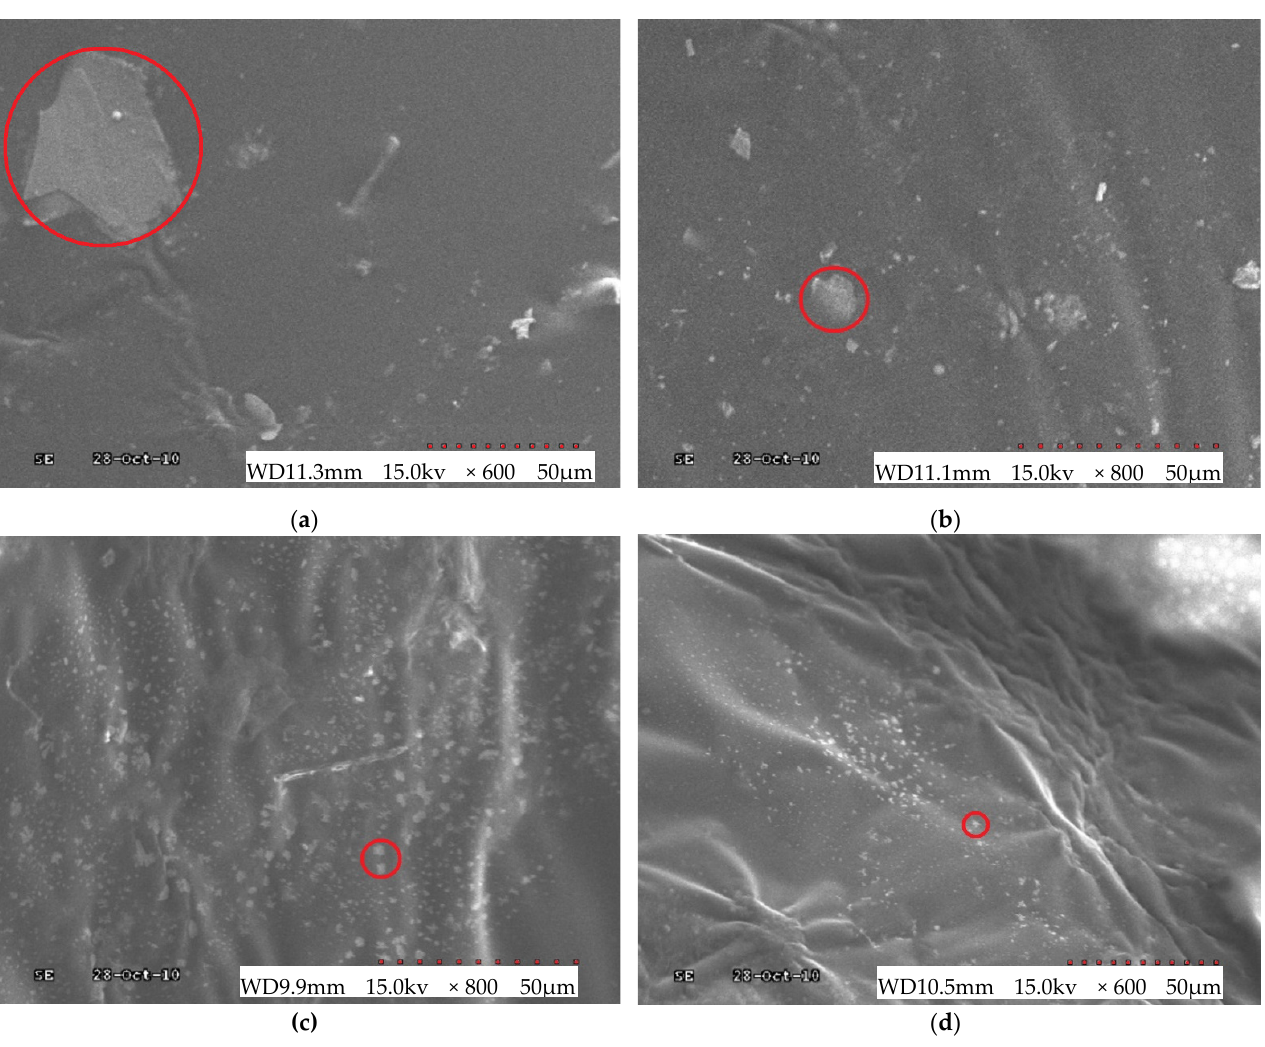
Figure 4. SEM of NMF modified asphalt: ( a ) 0% compatibilizer content (magnitude ×600); ( b ) 4% compatibilizer content (magnitude ×800); ( c ) 8% compatibilizer content (magnitude ×800); ( d ) 12% compatibilizer content (magnitude ×600).